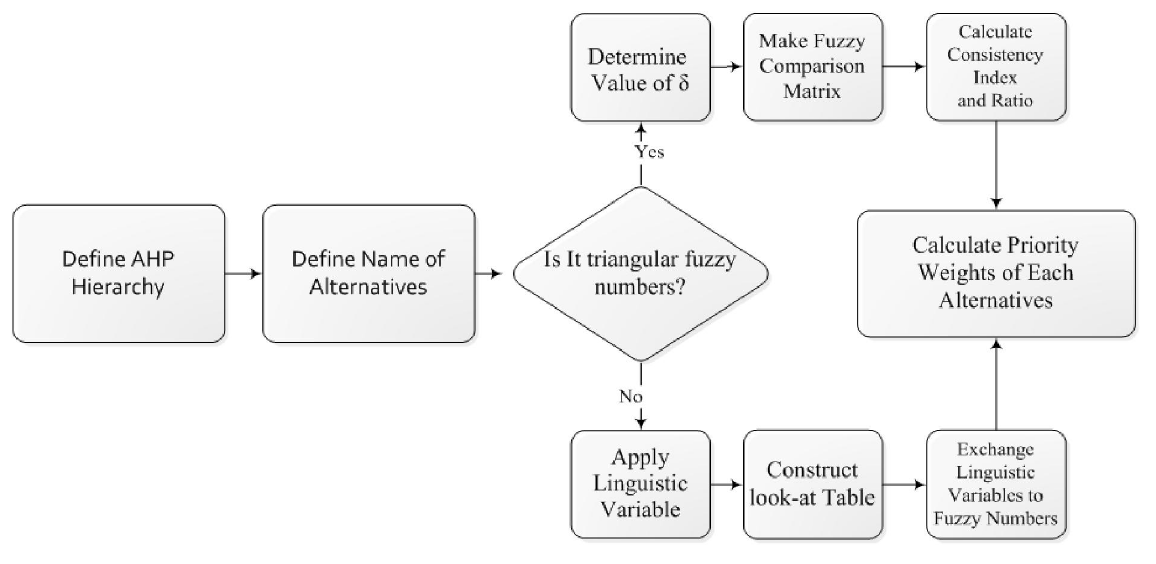
Fig. 3. Steps of fuzzy